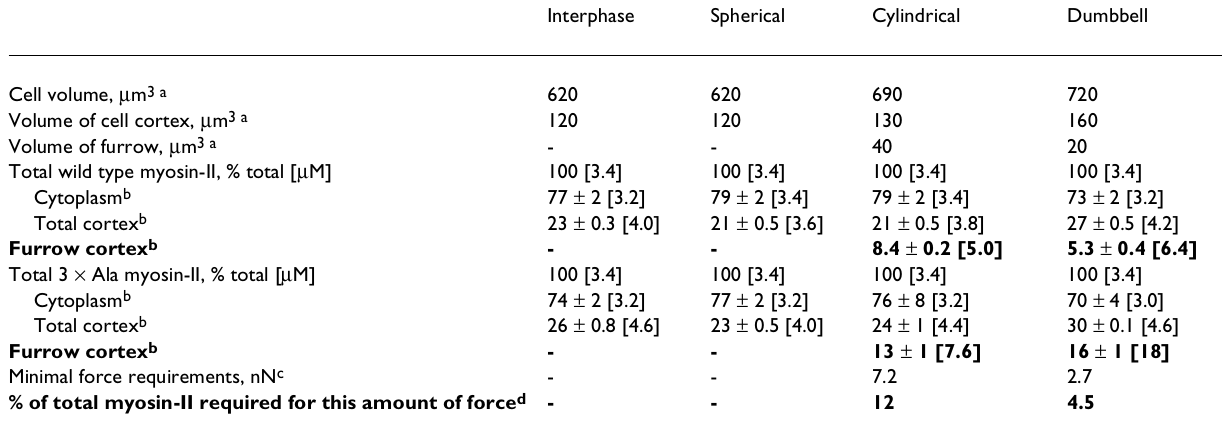
Table 1: Quantitation of myosin-II distribution during cytokinesis : Comparison with minimal force